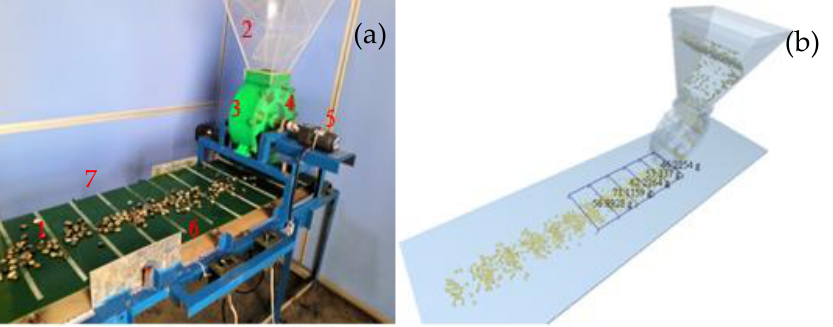
Figure 5. Clam seeding verification test: ( a ) direct seeding test: 1 Clam; 2 Blanking hopper; 3 Seeding tray; 4 Seeding wheel; 5 Motor; 6 Conveyor belt; 7 Grid ( b ) DEM simulation seeding test.